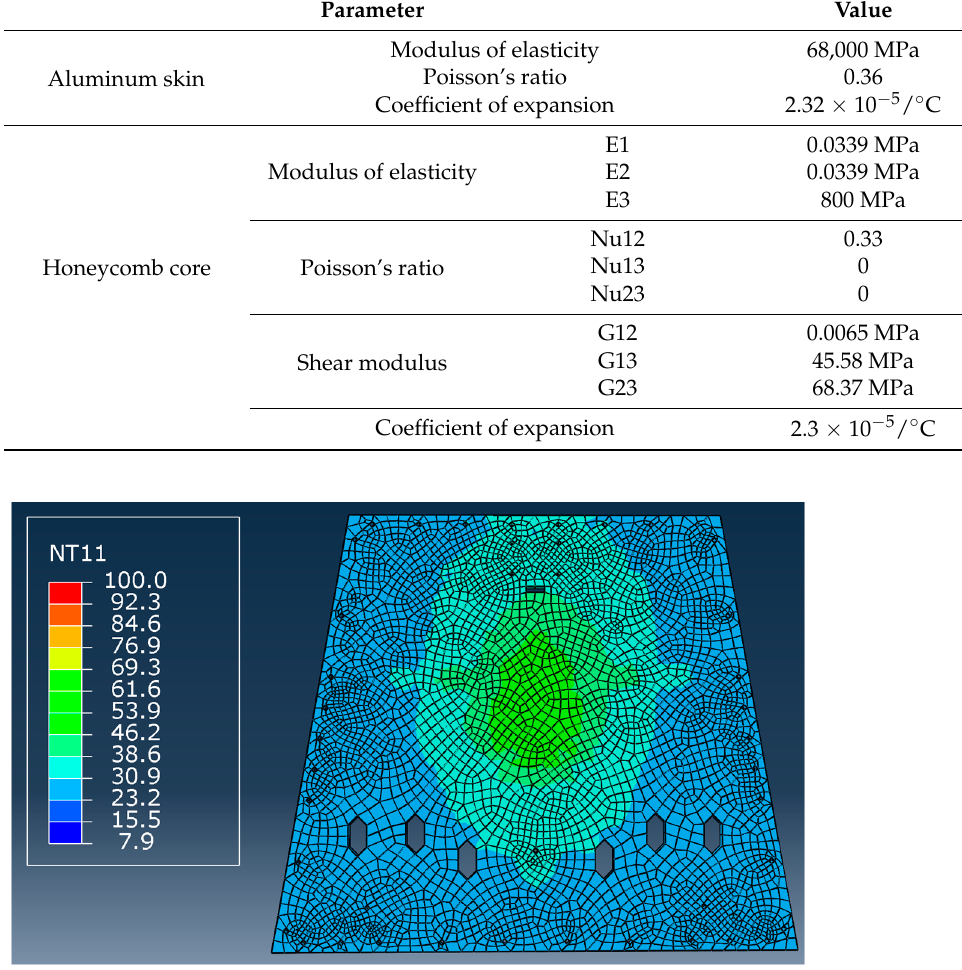
Figure 11. Simulated temperature field (unit: centigrade). Table 3. Equivalent boundary condition